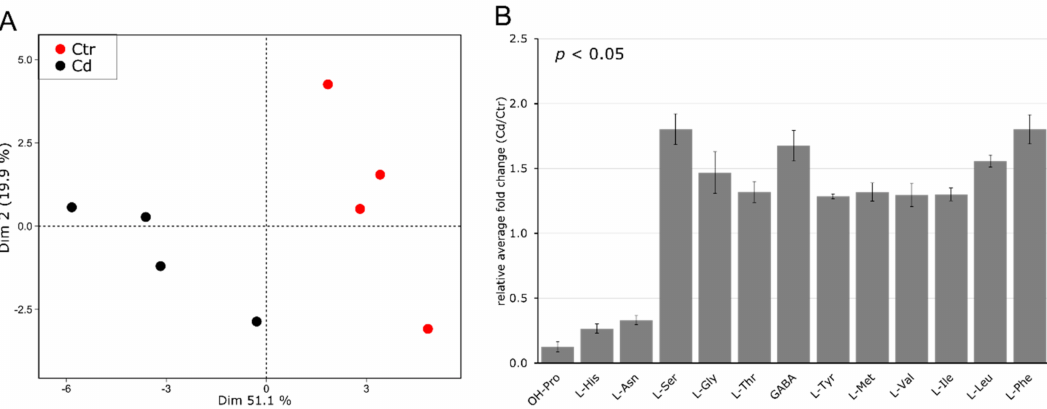
Figure 2. Amino acid profile in M. sativa stems after long-term exposure to Cd (10 mg kg − 1 soil dry weight). Amino acids were measured using UHPLC–DAD ( n = 4). ( A ) Principal component analysis. Dim 1 and 2 represent together 71% of the observed variance ( B ) relative fold change of significantly changed AA ( ± SEM). Significance was determined with a t -test at p ≤ 0.05. Absolute values for all AAs are provided in Table